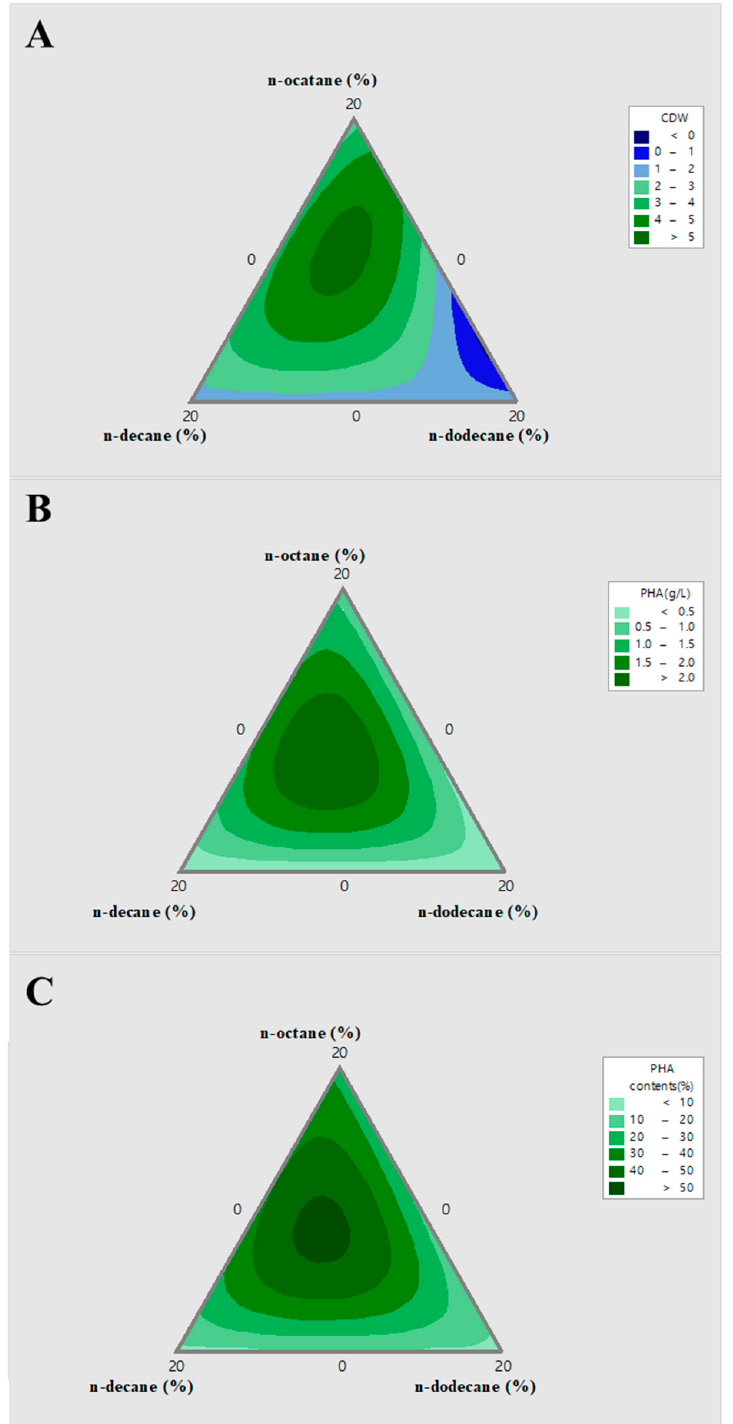
Figure 3. Mixture contour plots of mixed alkane composition for PHA production. The optimal composition ratio between n-octane, n-decane, and n-dodecane was determined as 20% ( v / v ) as a total concentration. ( A ): CDW (g/L), ( B ): PHA (g/L), and ( C ): PHA content (%) of different mixed alkane compositions. Contour plots for cell growth predicted the best ratio to be when n-octane, n-decane, and n-dodecane are 10.36%, 5.48%, and 4.5%, respectively, which produced CDW of 5.28